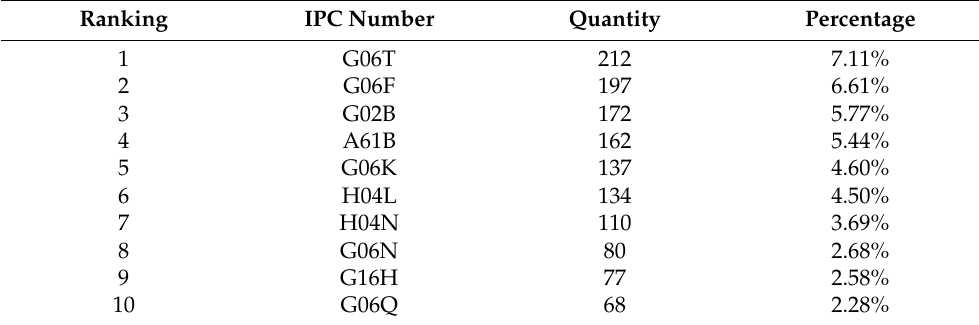
Table 1. Top ten three-level IPC numbers related to machine learning and